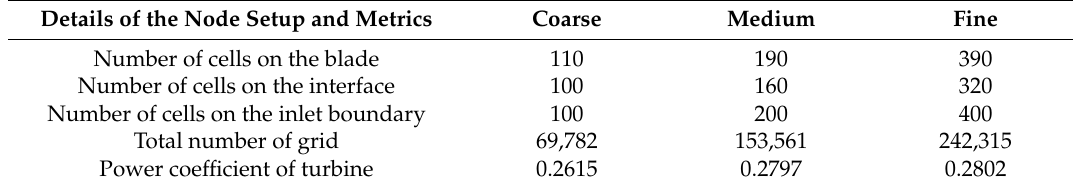
Table 3. Main detail sizes of three different grid resolutions.